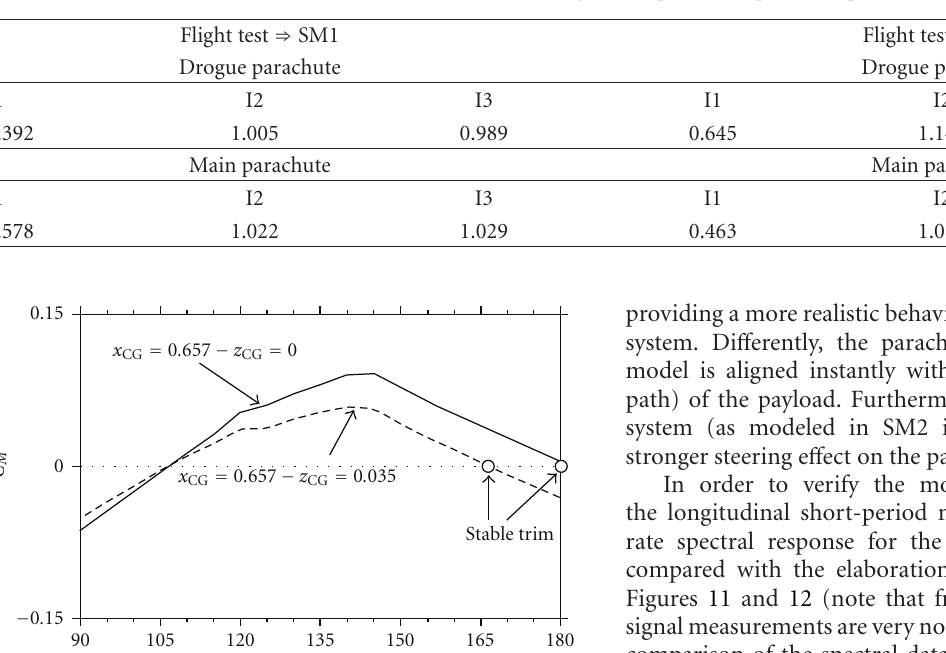
Table 2: The index of similarity for the pitch rate spectral response.